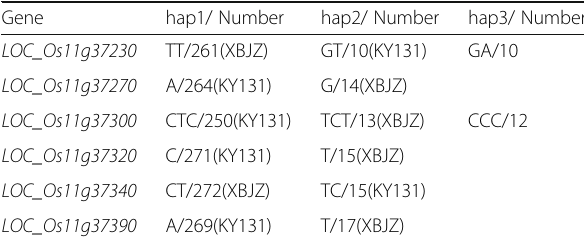
Table 3 Candidate gene haplotype group and the composition of each haplotype SNP